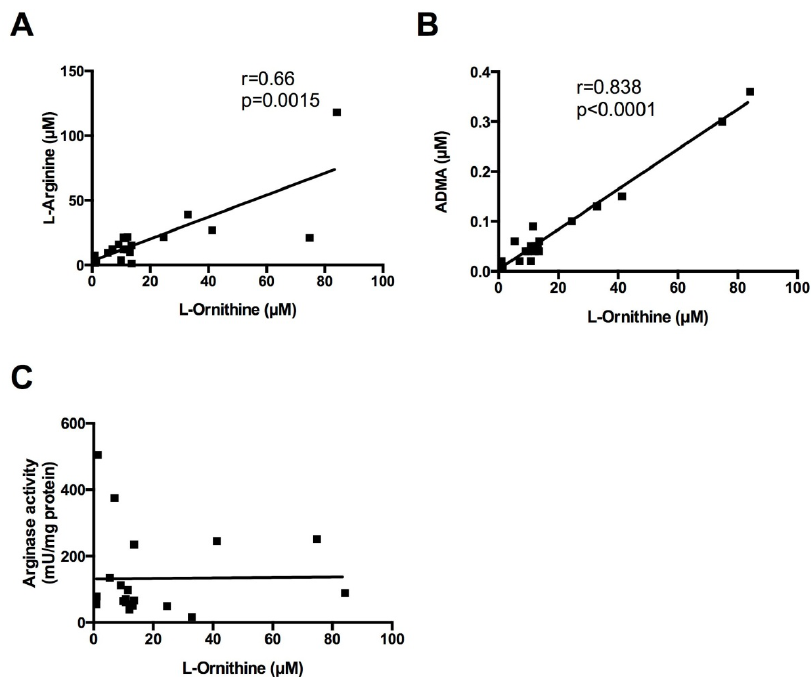
Figure 3. L -Ornithine levels correlate directly with L -arginine ( A ) and ADMA ( B ); but not in vitro arginase activity ( C ), in sputum samples obtained from the COPD patients. Spearman’s correlation coefficient and p -values are as